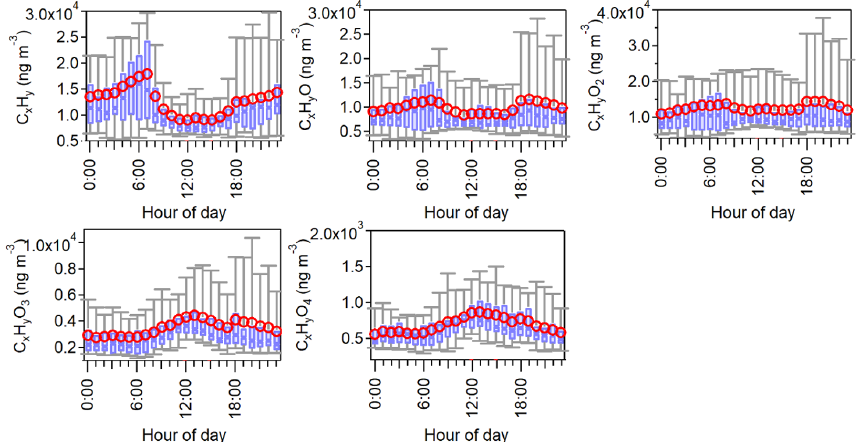
Figure 4. Diurnal variations of observed gas-phase species with a generic formula of C 2 − 13 H 2 − 22 O 0 − 4 . Hourly average values (ngm − 3 ) , together with 10th, 25th, 75th, and 90th percentiles, are also